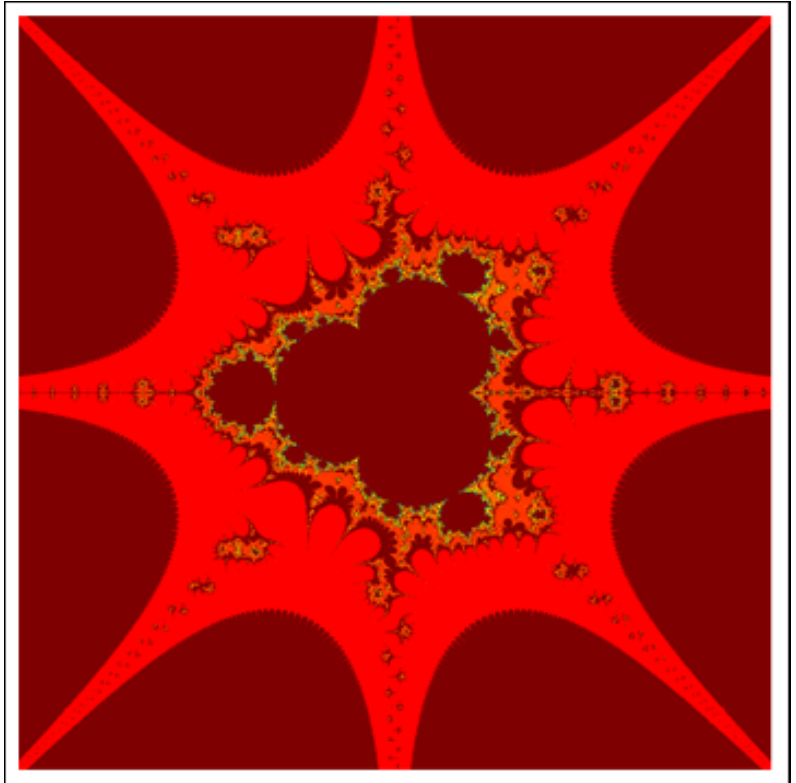
Figure 21. M-set for τ ( z ) = sin ( z 4 ) + c via DKIS. The image execution time is 532.875